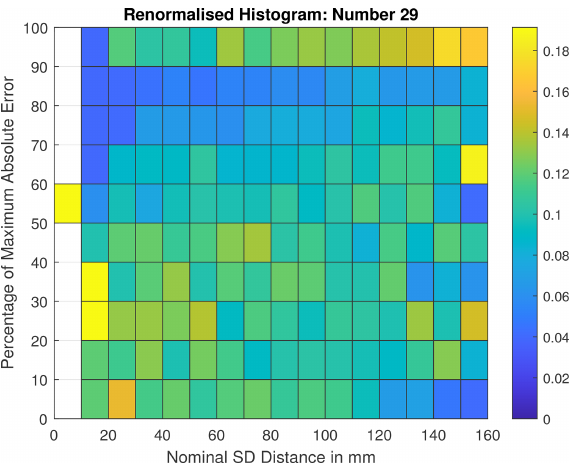
Figure 7. Renormalised bivariate histogram of SD measurement errors and nominal sphere distances as explained in Sect. 4.2. The phase angle set number 29 is the one with the lowest value of σ (meaning that the error distribution is most wide and most homoge- neous) and thus the one selected for further